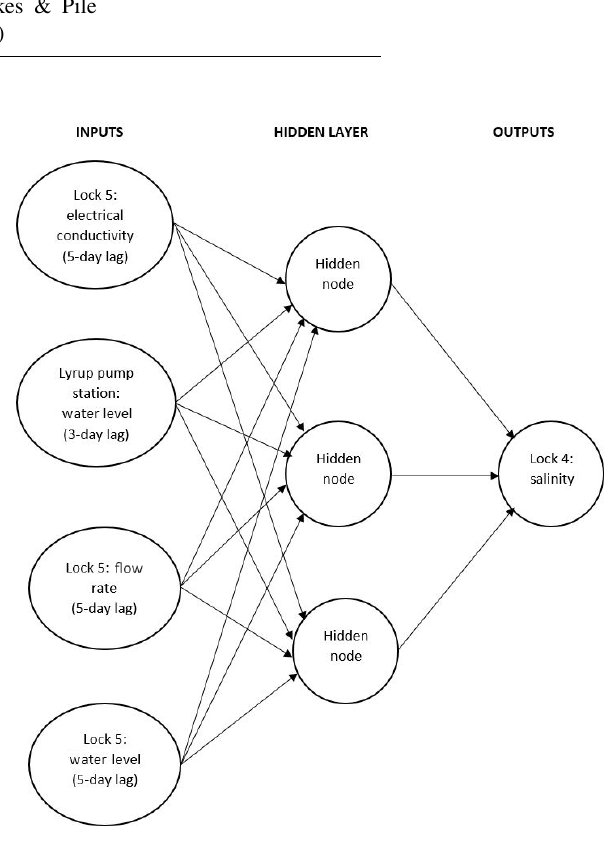
Figure 8. Structure and inputs of the benchmark